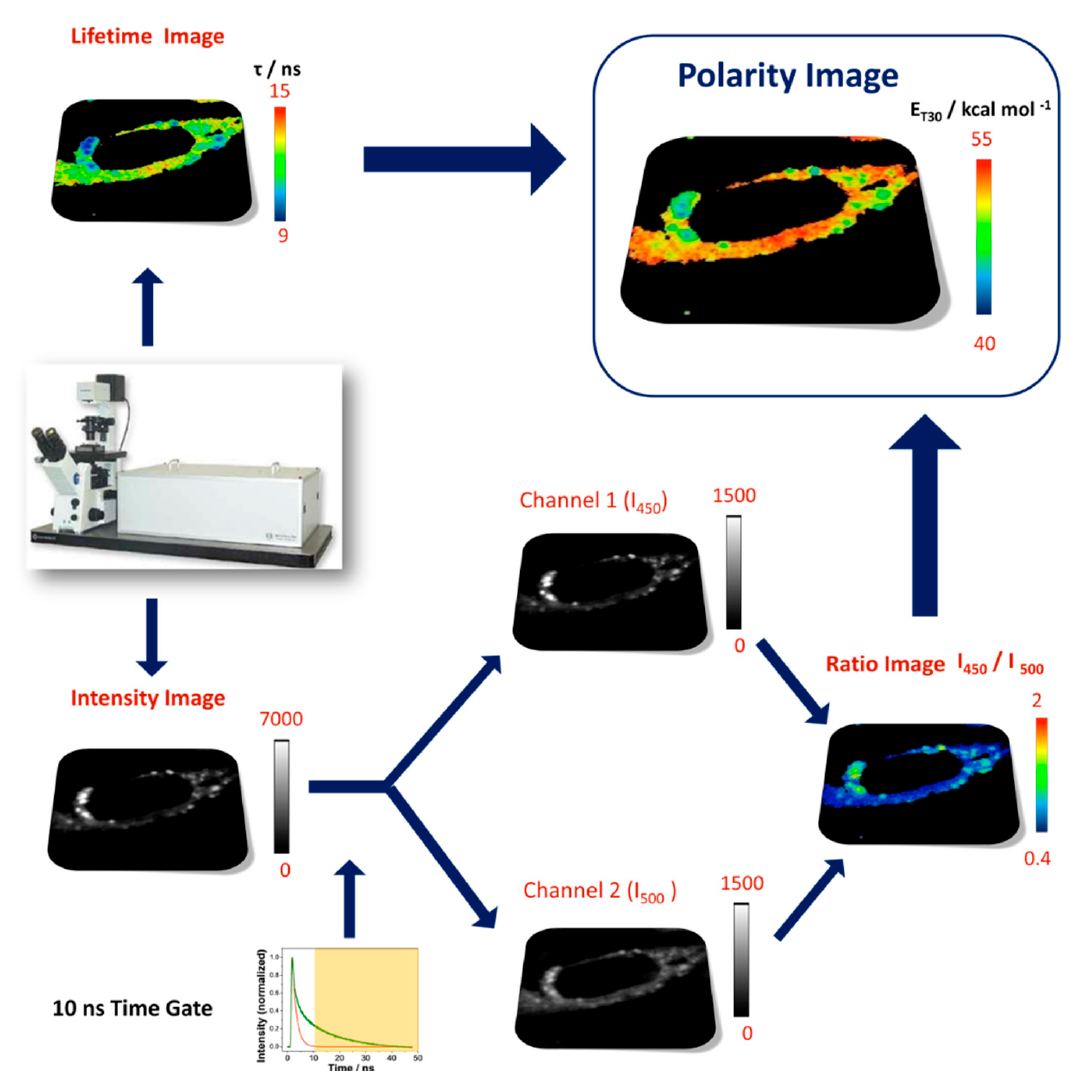
Figure 4. Scheme of the method to obtain accurate intracellular dipolarity images, in terms of the E T 30 parameter, through multiparametric fluorescence microscopy.